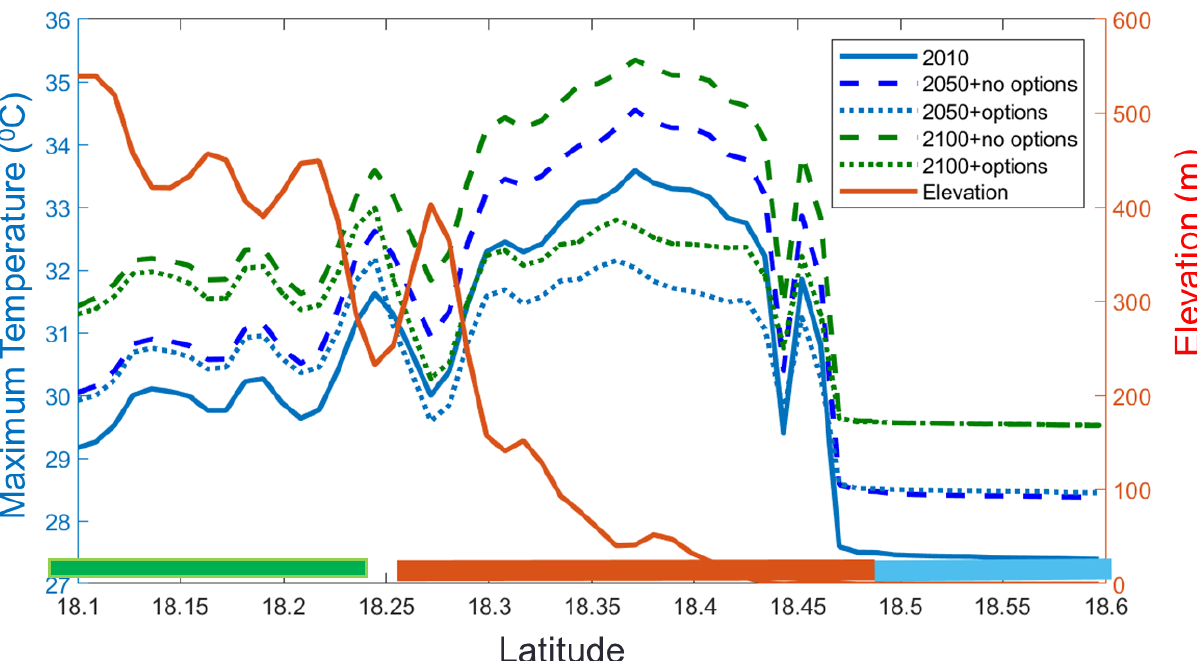
Figure 11. The 2 m air maximum temperature for historic (2010), mid-century, and end-of-century periods with and without mitigation measures passing through − 66.1° longitude over San Juan. The thick dark red line indicates urban area, thick blue line indicates ocean, and thick green line indicates rural area.